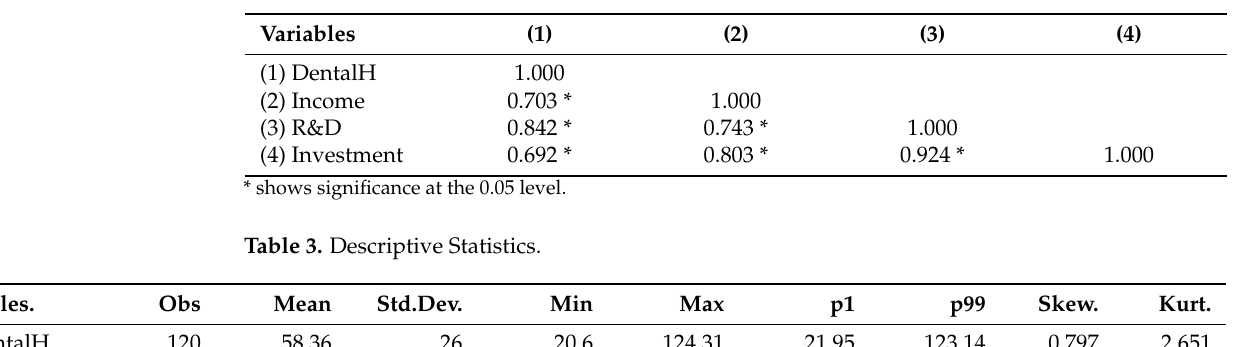
Table 2. Pairwise correlations.